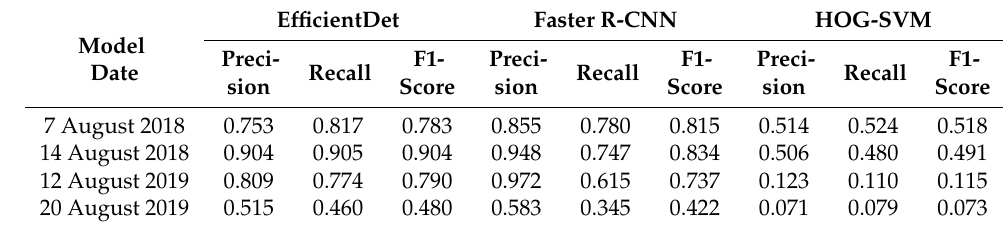
Table 8. Evaluation of model performance on four datasets.